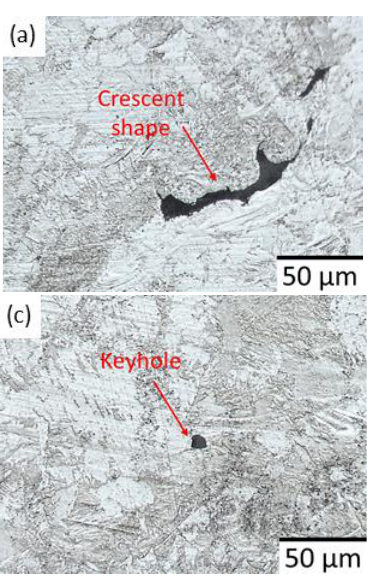
Figure 13. The types of porosity observed from three different areas of 90° build direction; ( a ) crescent shape, ( b ) unmelted powder, ( c ) keyhole and ( d ) spherical porosity.